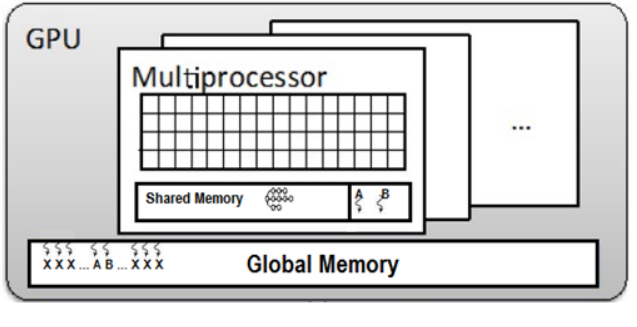
Figure 8: Storing the transition table of State machine in shared